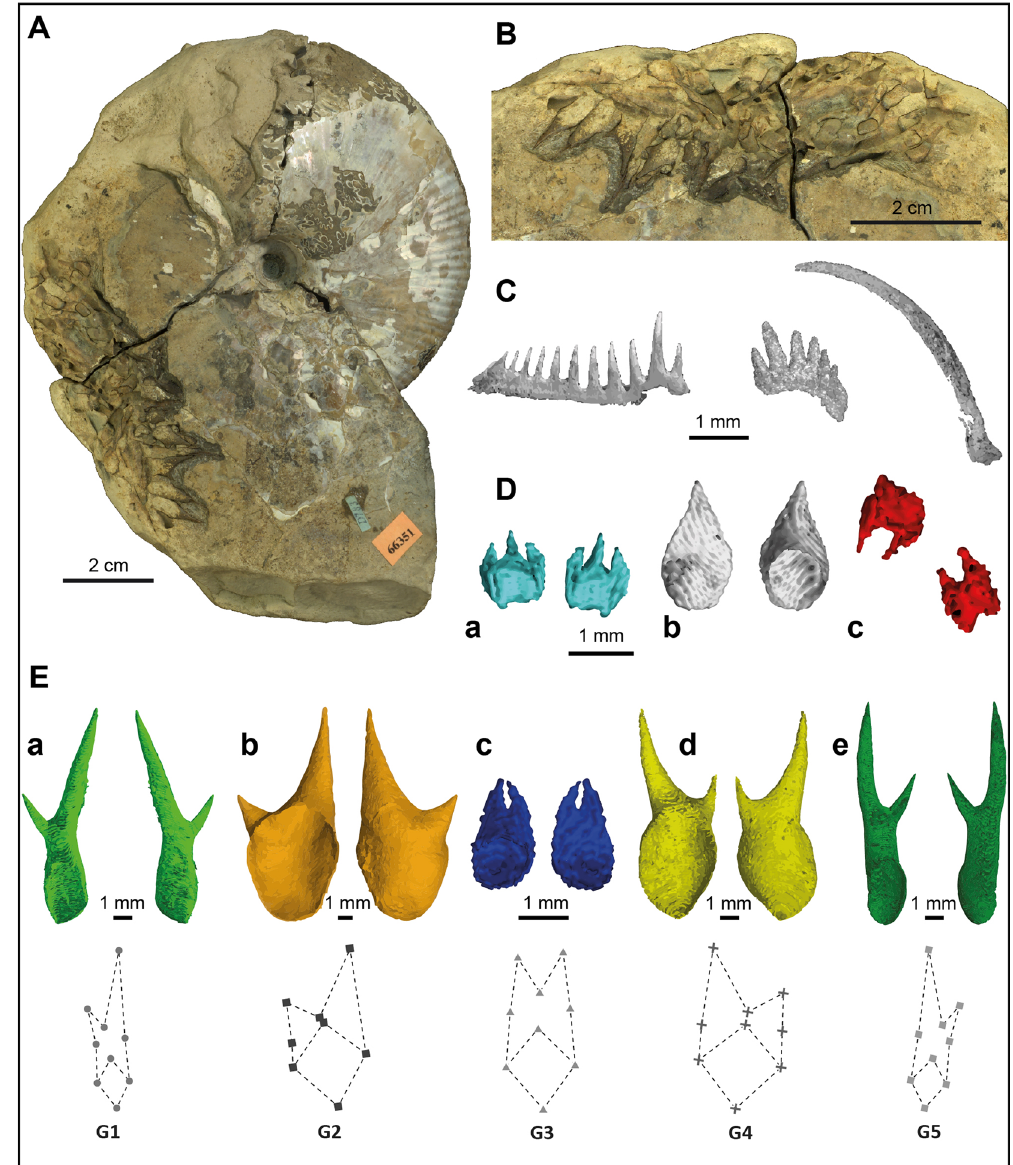
Figure 2. Rhaeboceras halli hooks. ( A ) R. halli , AMNH 66351 with hooks occurring at the edge of the body chamber. ( B ) Close-up view of the hooks in AMNH 66351. ( C ) R. halli radular teeth identified by Kruta et al. 31 ; from left to right: second lateral tooth, first lateral tooth and marginal tooth. ( D ) & ( E ) 3D rendering (VGStudio MAX 3.0.) of the structures identified in Kruta et al. 32 . ( D ) (a) tricuspid, (b) unicuspid, (c) very small bicuspid structures. ( E ) The five main bicuspid morphotypes and their typical